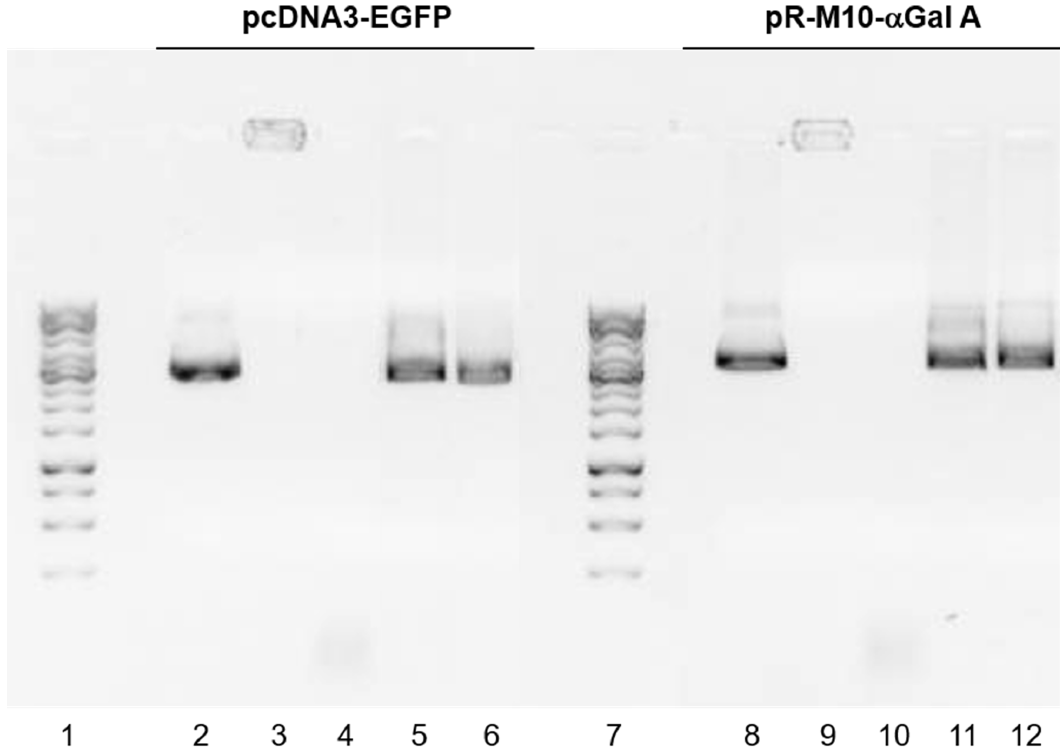
Figure 5. Capacity of the GM-SLN vector to bind, protect and release pcDNA3-EGFP and pR-M10- α Gal A by agarose gel electrophoresis. (1) 1 Kb pDNA ladder. (2) Free pcDNA3-EGFP. (3) GM-SLN vector. (4) Free pcDNA3-EGFP + DNase. (5) GM-SLN vector + DNase. (6) GM-SLN vector + SDS. (7) 1 Kb pDNA ladder. (8) Free pR-M10- α Gal A. (9) GM-SLN vector. (10) Free pR-M10- α Gal A + DNase. (11) GM-SLN vector + DNase. (12) GM-SLN vector +